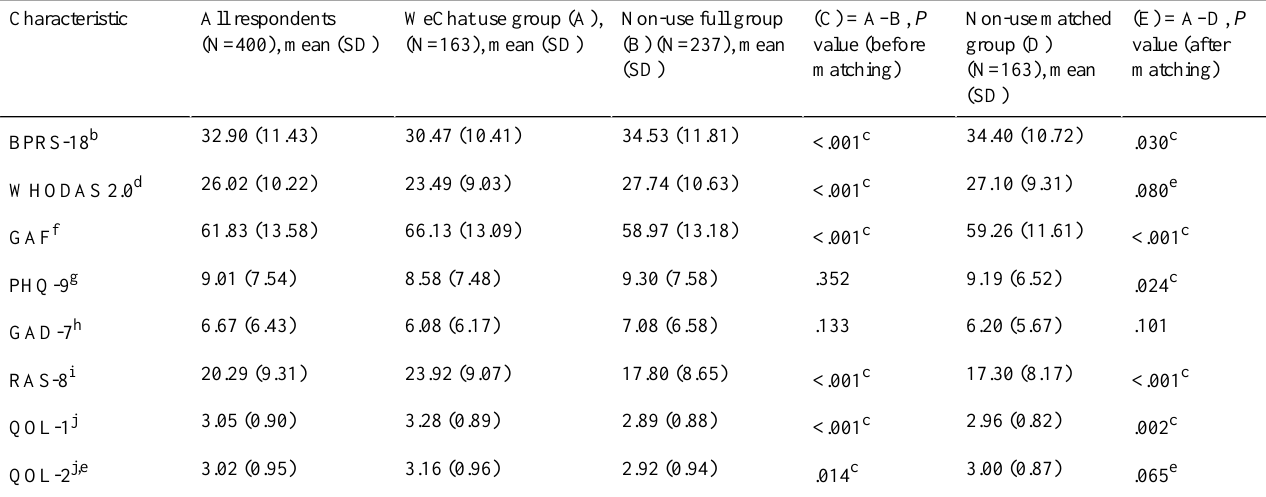
Table 4. Health outcome comparison between the WeChat use group and nonuse group. a